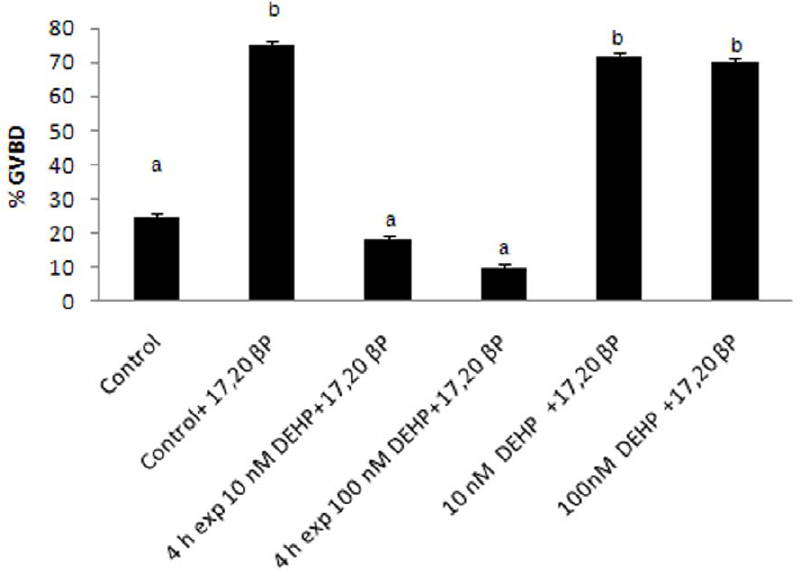
Figure 2. Pre-exposure of DEHP inhibits steroid-induced germinal vesicle breakdown (GVBD) invitro . Stage IIIB follicles were collected from female zebrafish and were pre-exposed to DEHP for 4 hrs before addition of 17,20 b P, or simultaneously exposed to DEHP and 17,20 b P. Data represent mean 6 SD of three replicate wells from one experiment. The experiment was repeated three times with similar results. Different letters indicate statistical significant differences compare to control group (p , 0.05).